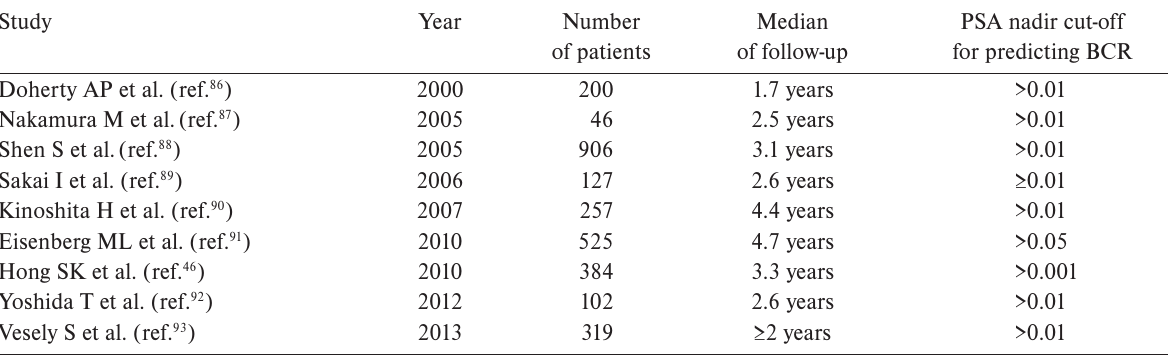
Table 2. Summary of studies proving the significant capability ( P <0.001) of ultrasensitive PSA nadir to predict BCR after radical